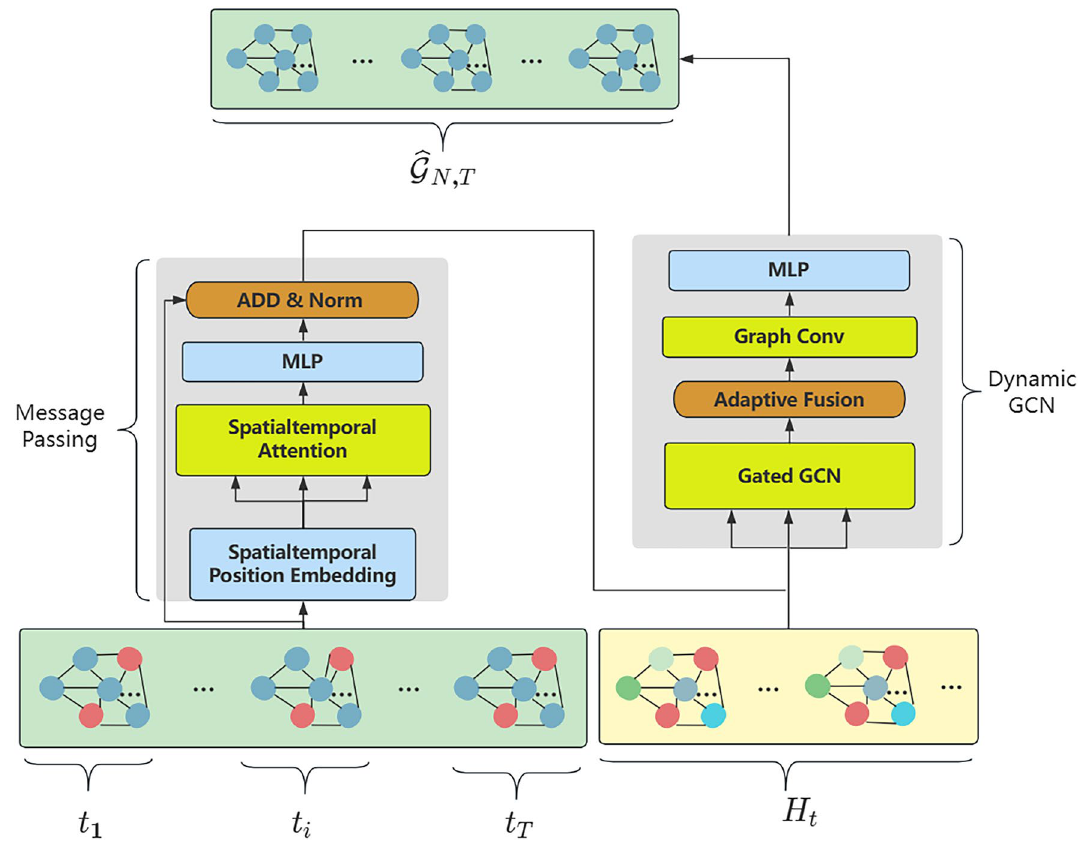
Figure 1. ADGCN Model architecture.